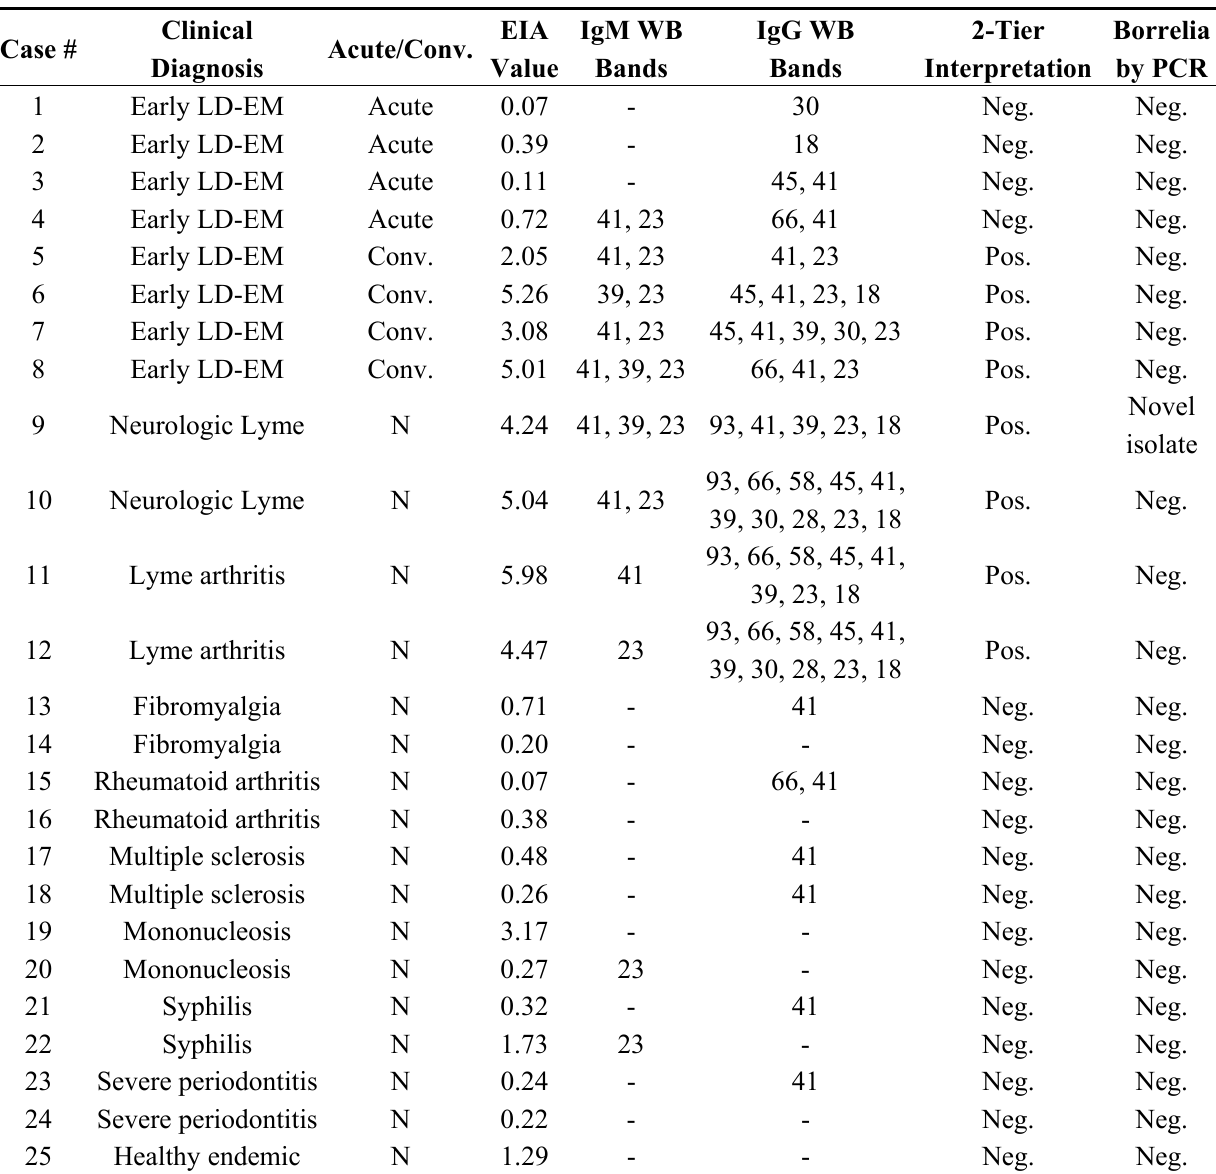
Table 1. Results of 2-tier serology test and PCR detection of borrelia in split serum samples from post-treatment Lyme disease patients and